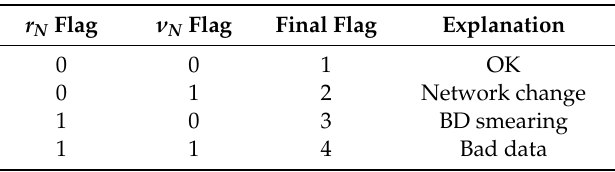
Table 1. Measurement set